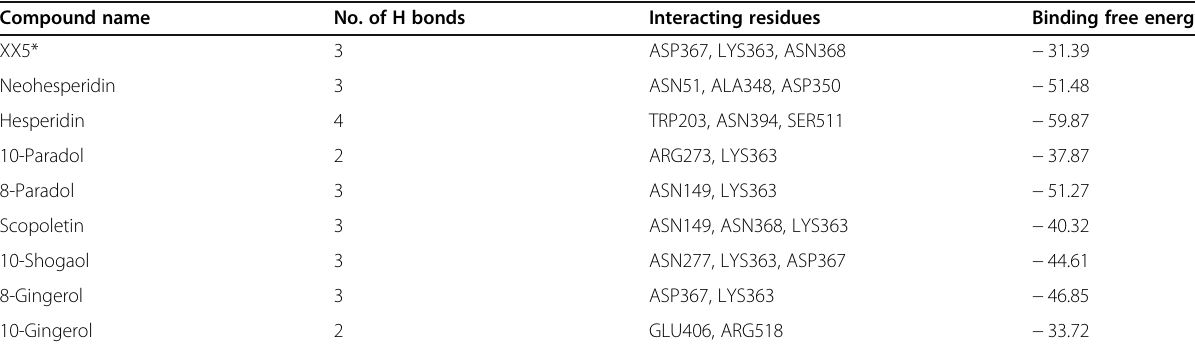
Table 4 Binding free energies of top scored compounds and control at the active site of ACE-2 Compound name